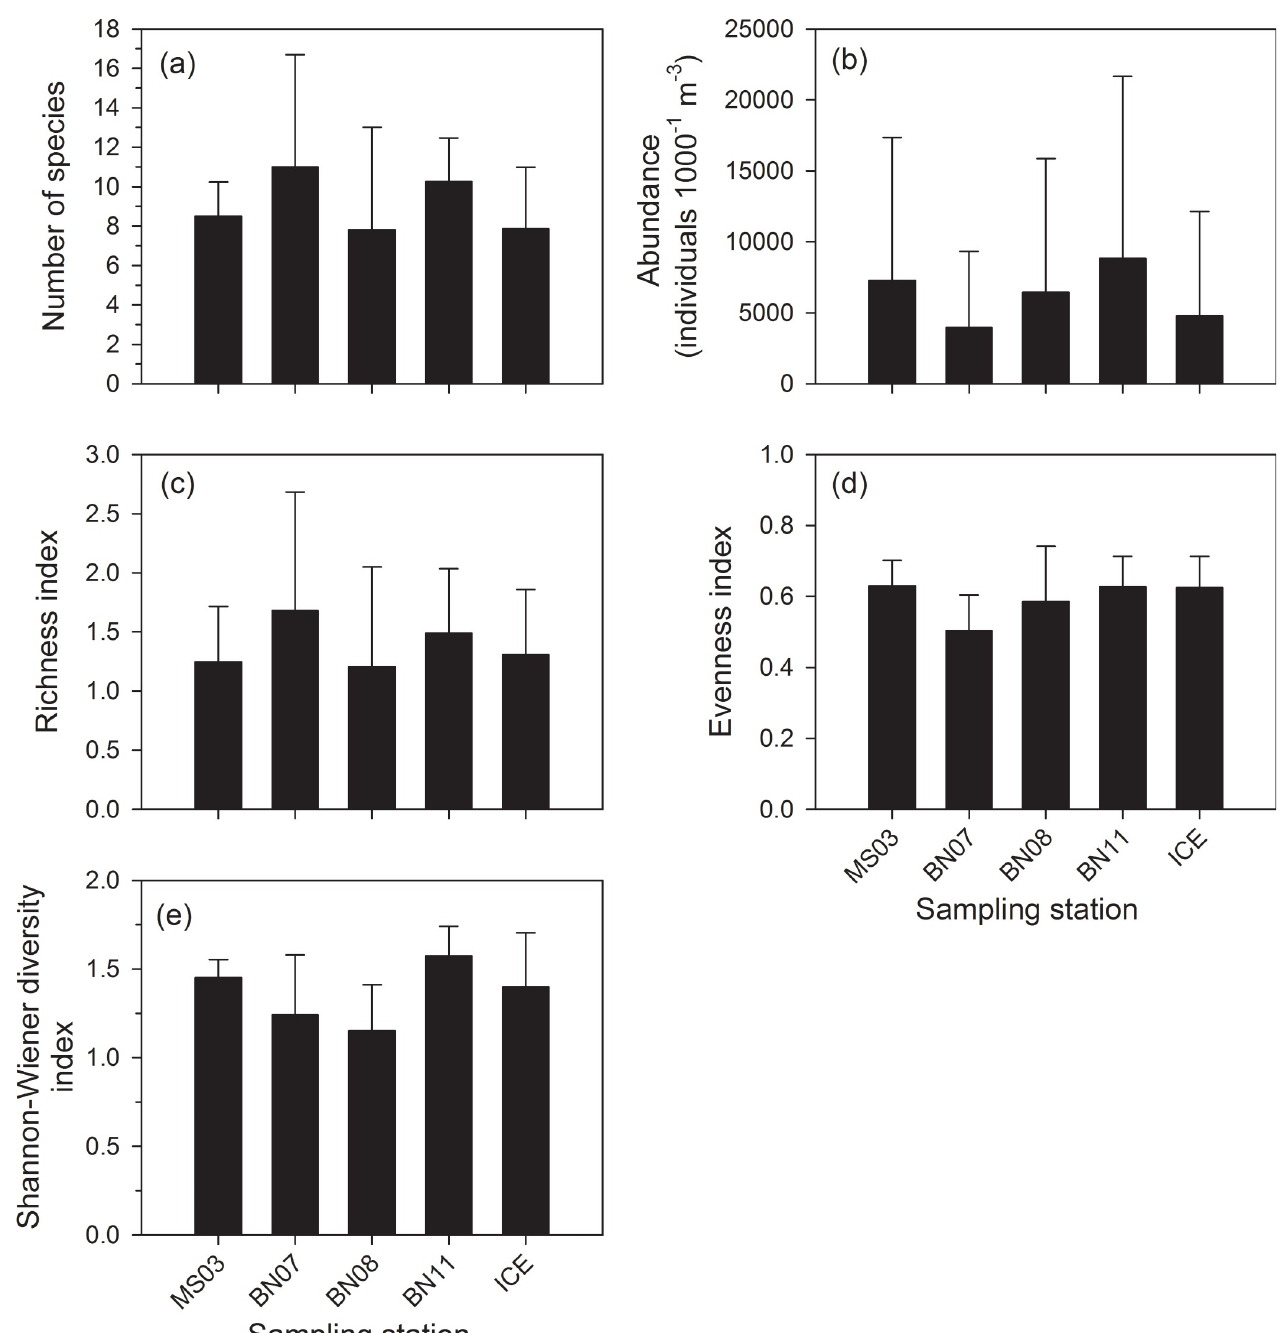
Fig 7. Comparisons of (a) abundance, (b) number of species, (c) indices of richness, (d) evenness, and (e) diversity from 5 sampling stations by using one-way ANOVA followed by the Tukey